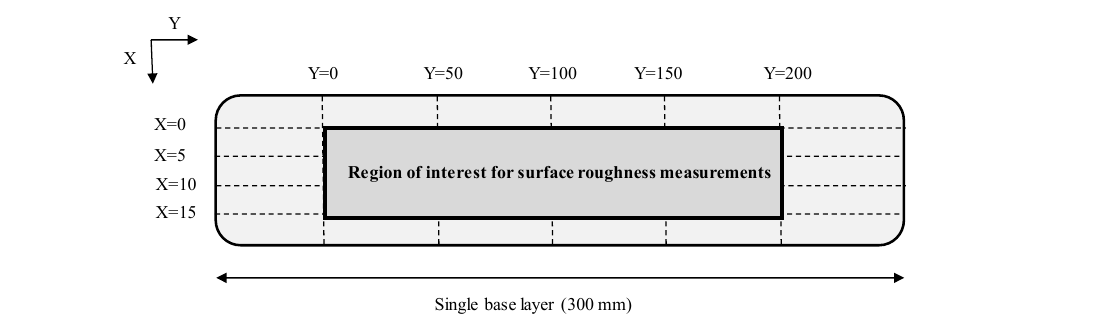
Figure 2. Schematic representation of the surface roughness measurements (ALM).